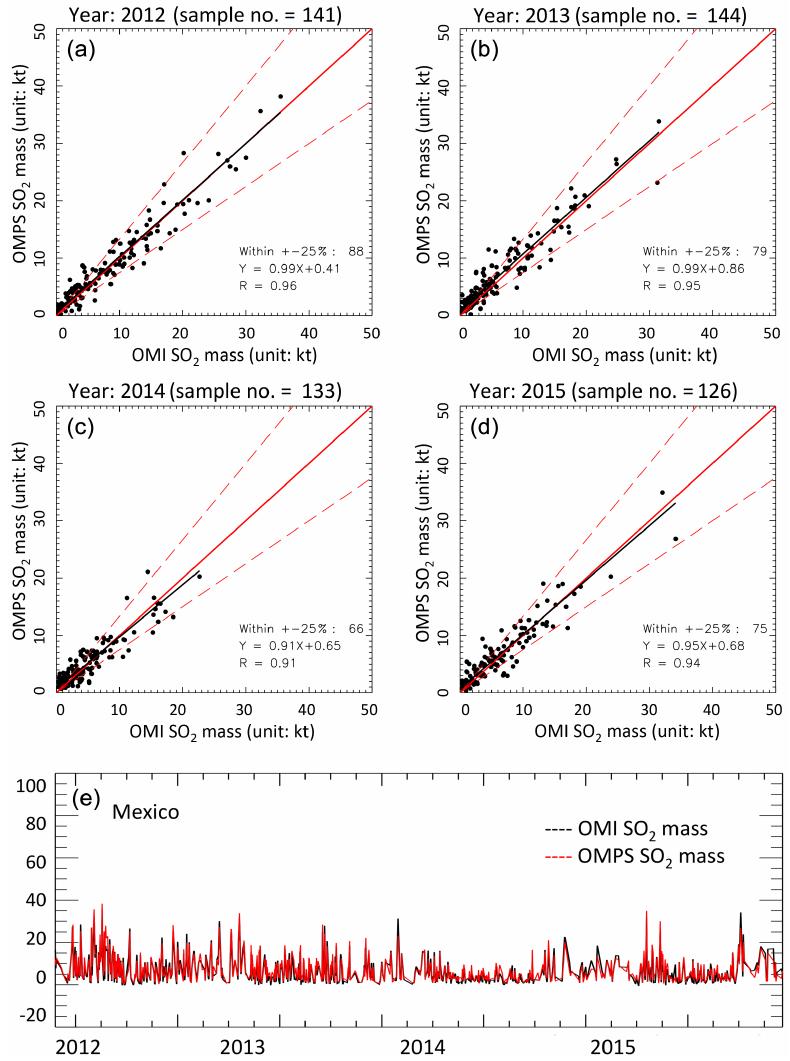
Figure 4. Same as Fig. 3 but for the Mexico